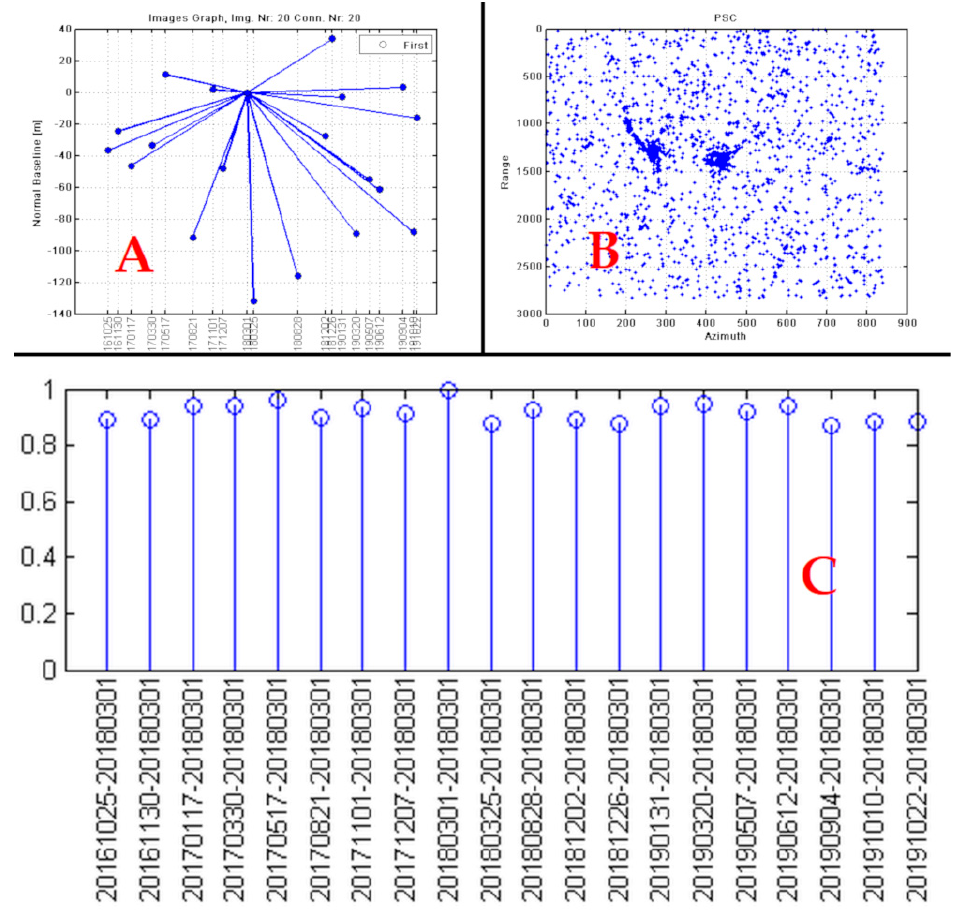
Figure 7. ( A ) Representation of the Sentinel 1 B image set, in the normal basal–temporal space, where each point and line represents an image and an interferogram, respectively. ( B ) Scattered points for PS-InSAR analysis. ( C ) Consistency greater than or equal to 0.85 of the Sentinel 1 image stack.